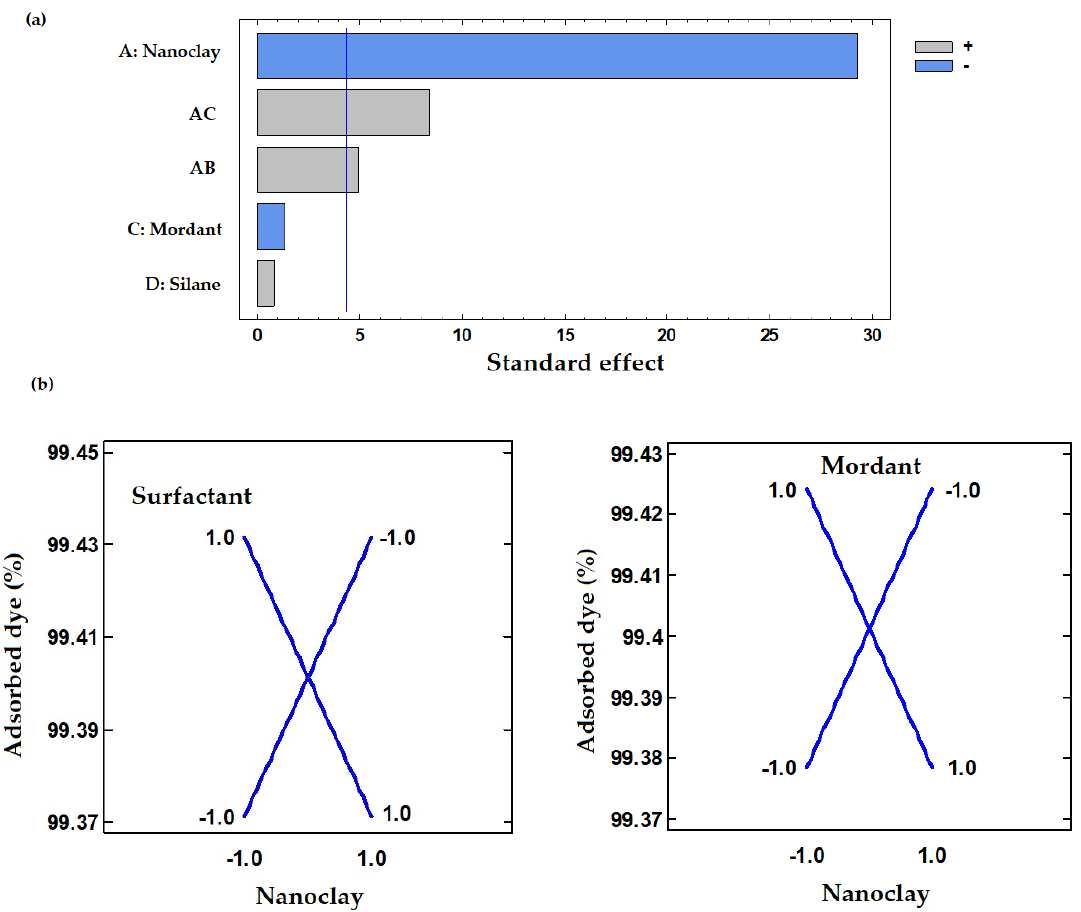
Figure 1. Pareto ( a ) and interactions ( b ) plots obtained to maximize the adsorption of lemon dye into the nanoclays.